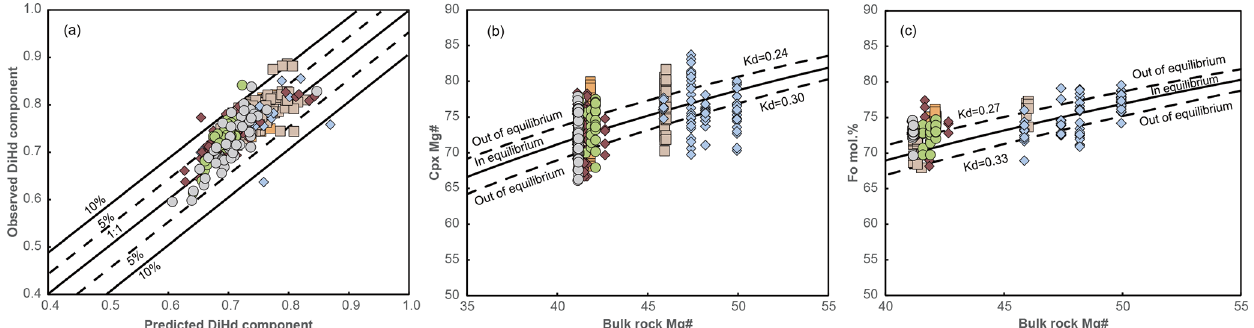
Figure 8. Tests for equilibrium between clinopyroxene or olivine and nominal melts. (a) Predicted vs. observed clinopyroxene mineral components (diopside–hedenbergite). The equilibrium region requires (cid:49) DiHd ≤ 0.1. (b) Rhodes diagram for clinopyroxene from the WVF showing equilibrium Kd Fe-Mg curve of 0.27 (solid line) and error limits of ± 0 . 03 (dashed lines) after Neave and Putirka (2017). (c) Rhodes cpx-liq diagram for olivine from the WVF; the continuous curves represent the equilibrium Kd Fe-Mg of 0.3, while the dashed lines represent the ol-liq error intervals of ± 0 . 03 (Putirka,